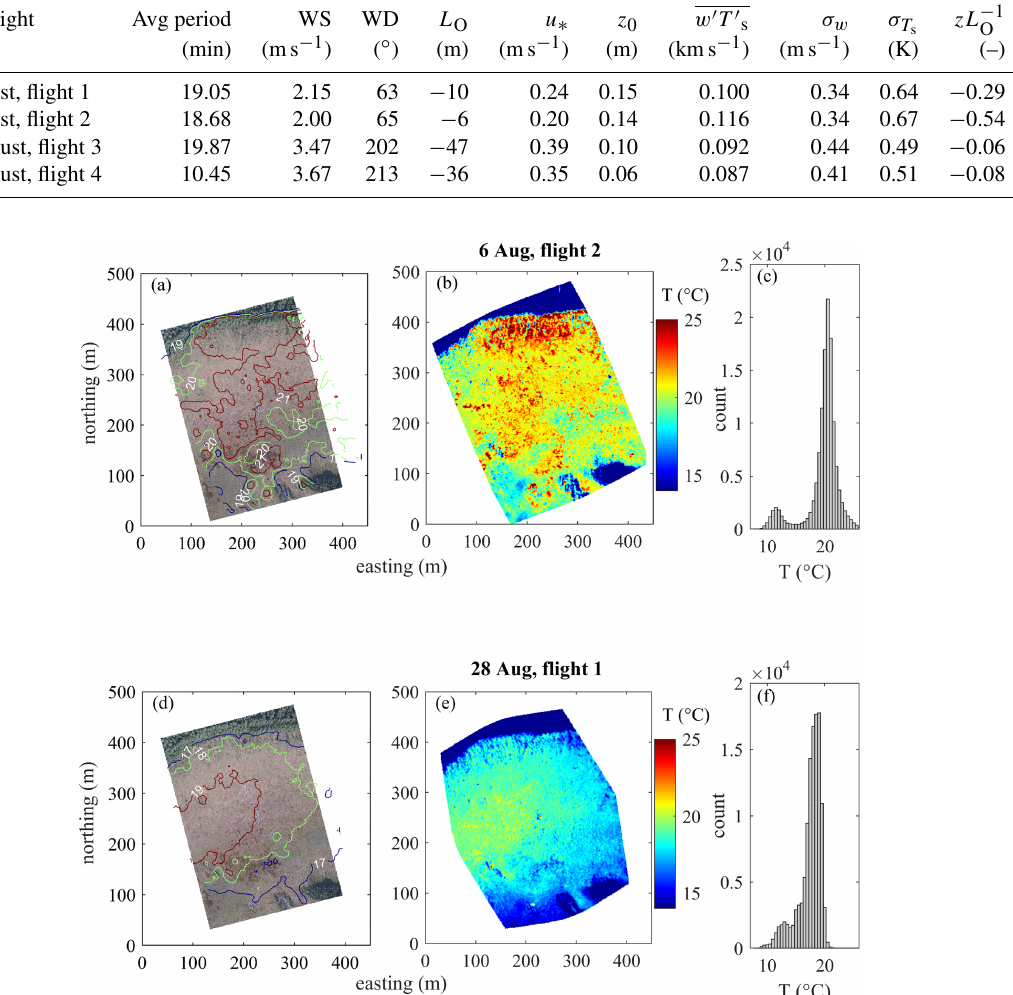
Figure 4. Pixel-mean surface temperature ( T (xy) ) measured by UAS-mounted thermal camera for the second flight of 6 August (a–c) and first flight of 28 August (d–f) . The surface emissivity was assumed uniform at 0.98. (a, d) RGB photographs with temperature isolines based on the calculated ˜ T (xy) ; (b, e) surface temperature averaged for all frames of a flight ( T (xy) ); and (c, f) histograms of T (x,y) shown in (b) and (e)